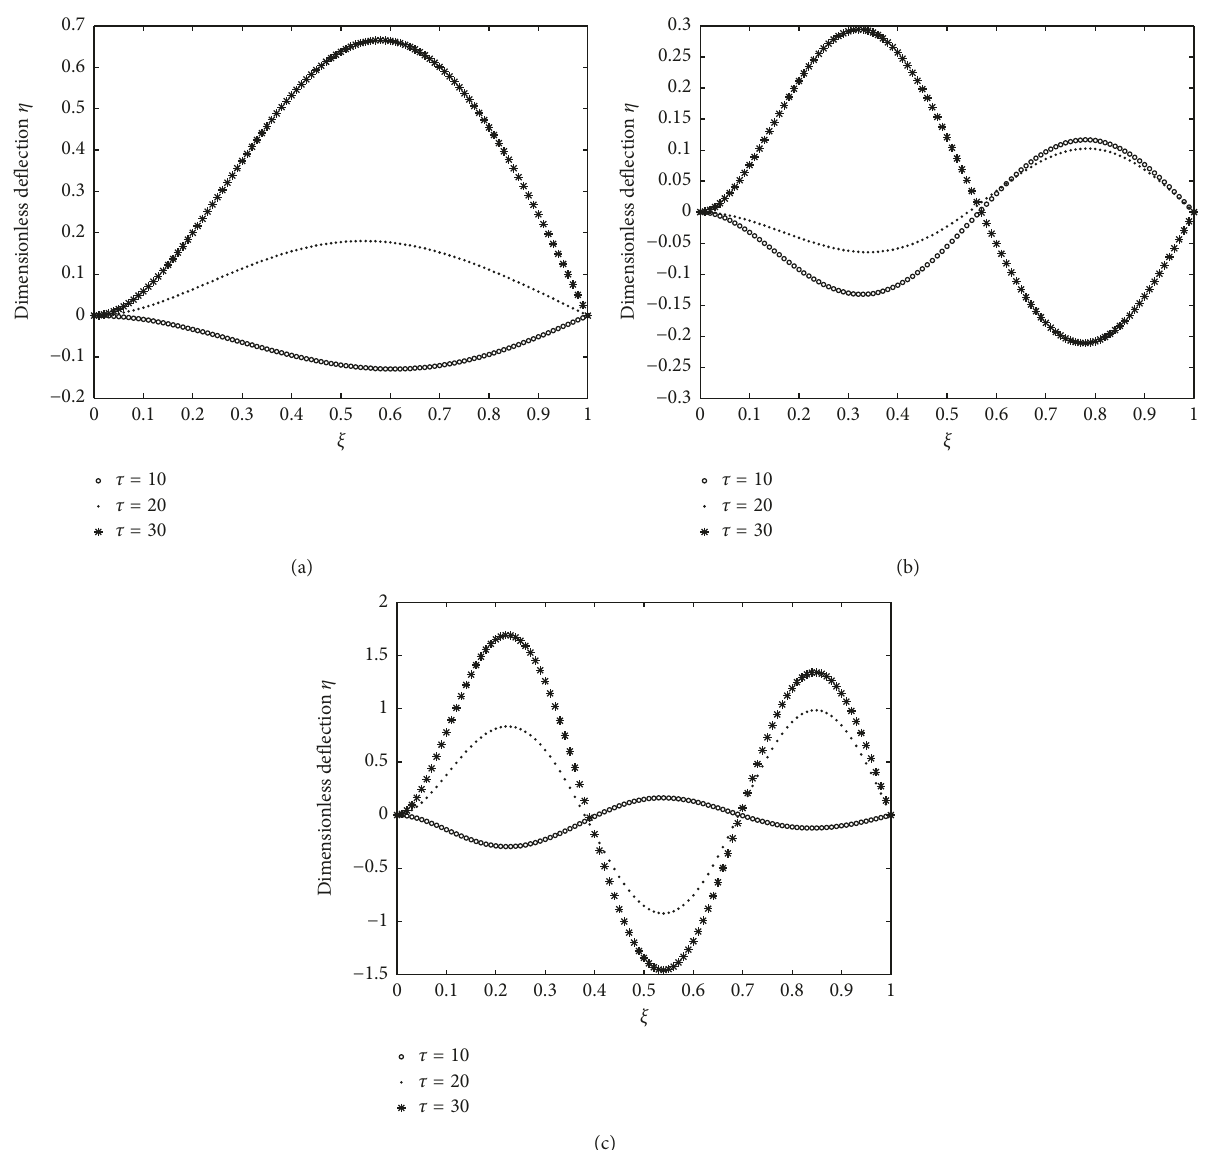
Figure 13: The resonance responses of the clamped-pinned pipe with u � 1 and different supports moving frequencies: (a) ω � 14.36; (b) ω � 48.89; (c) ω � 103.15.